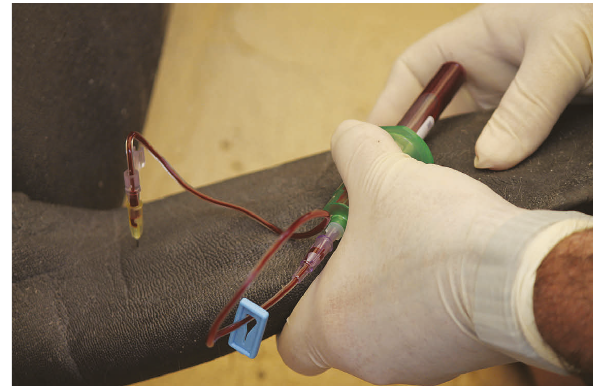
Figure 4: Venipuncture sampling on a subadult Antillean manatee from Puerto Rico using a 20-gauge X 1½-inch needle with a vacutainer and a 14-inch extension